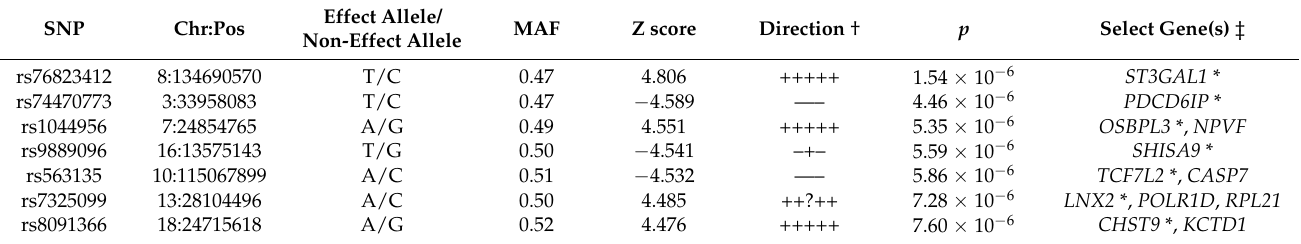
Figure 2. Manhattan plot of the meta-analysis results of the five early childhood caries (ECC) genome-wide association studies (GWASs). The horizontal red line represents the genome-wide significance threshold ( p = 5 × 10 − 8 ), and the horizontal blue line is the suggestive significance threshold ( p = 1 × 10 − 5 ). Each point represents a variant tested for association with ECC. The x -axis is the genomic position of the corresponding variant, and the y -axis is the negative logarithm of the association p -value. Seven loci surpassed the suggestive threshold of association with ECC, and none surpassed the genome-wide significance threshold. Table 2. Lead single nucleotide polymorphisms (SNPs) suggestively associated ( p ‐ value < 1 × 10 − 5 ) with early childhood caries (ECC) in the meta ‐ analysis.